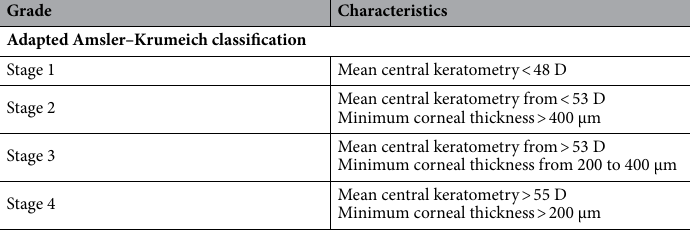
Table 4. Amsler–Krumeich classification. We only used topographic criteria, i.e. mean central keratometry readings and minimum corneal thickness.